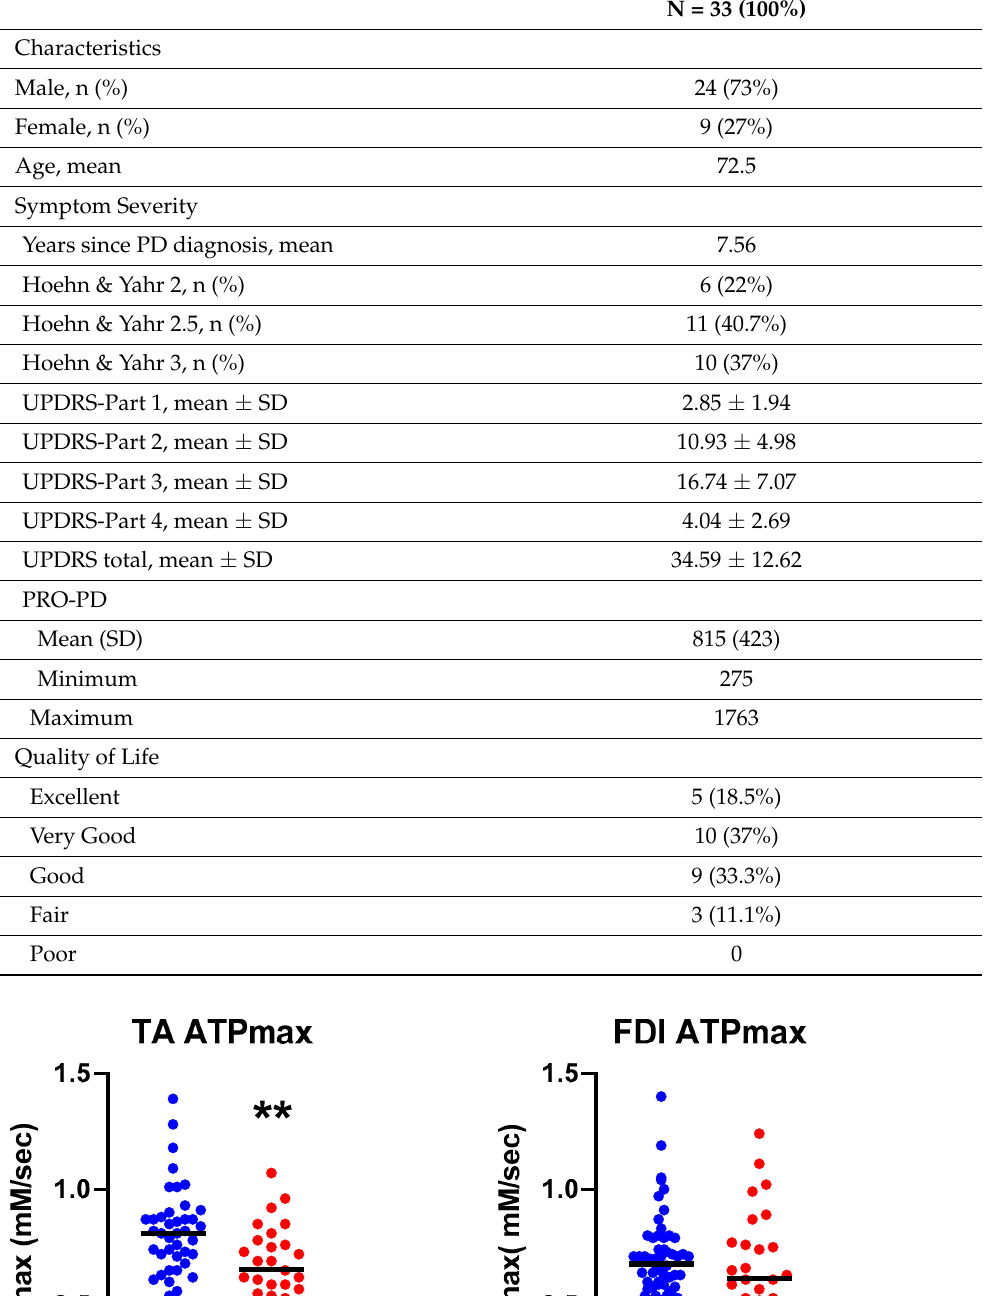
Table 1. Sample descriptive statistics.